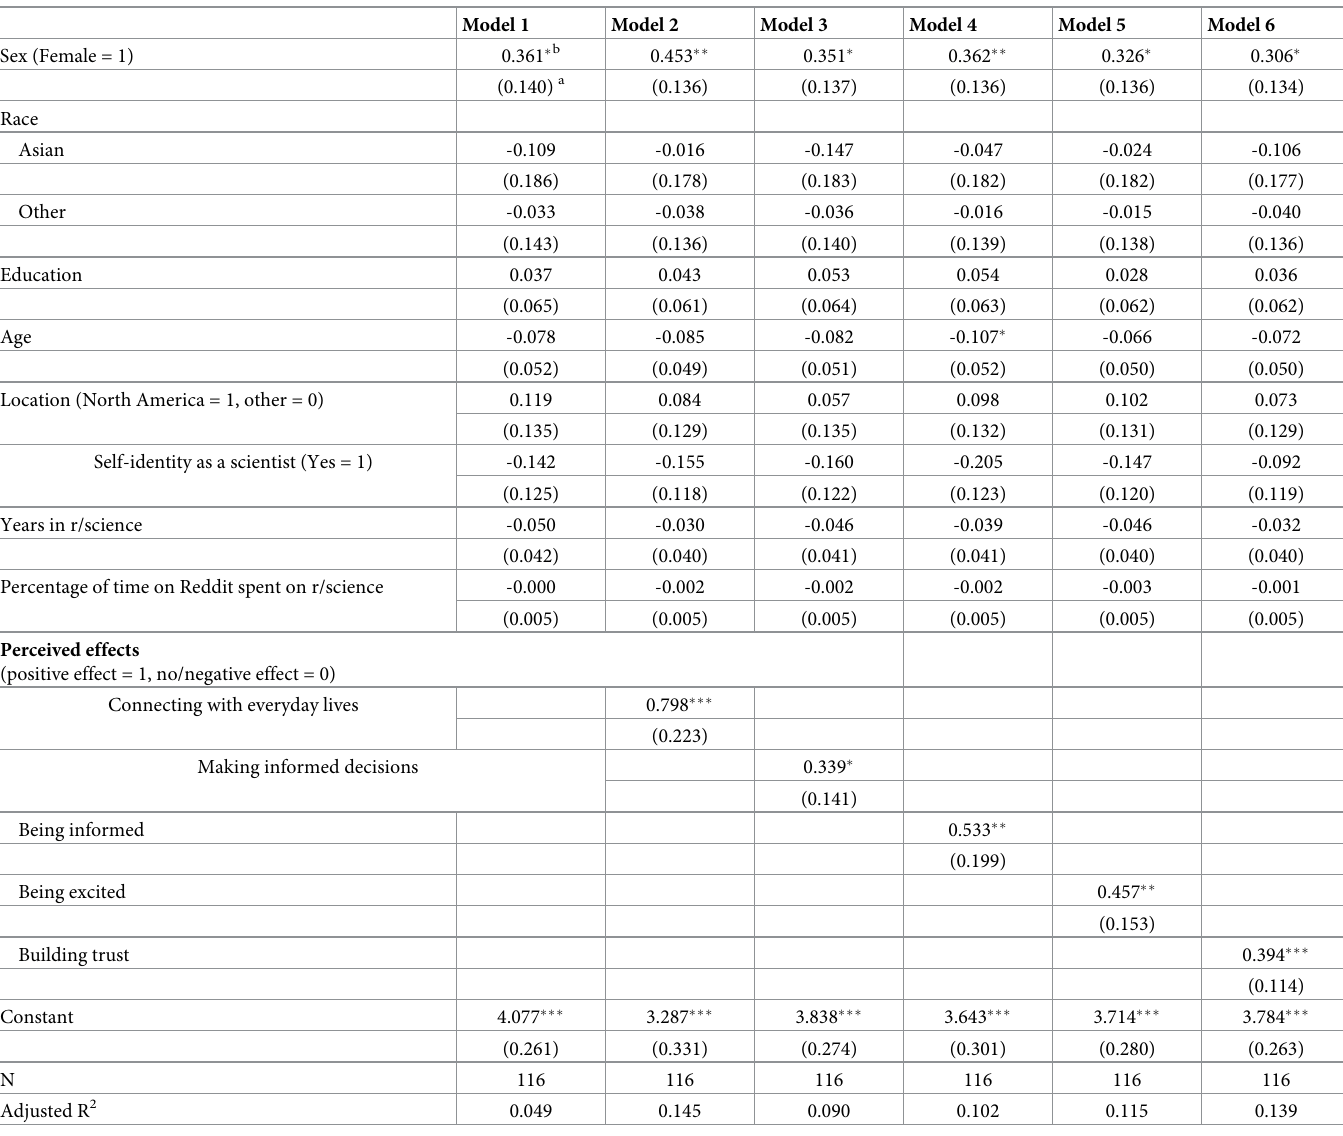
Table 3. Results of linear regression of users’ demographics and perceived effects on reward